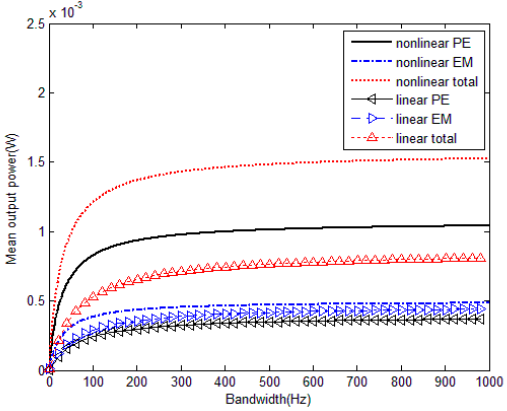
Figure 9. Mean output power of hybrid energy harvester with different excitation bandwidths.